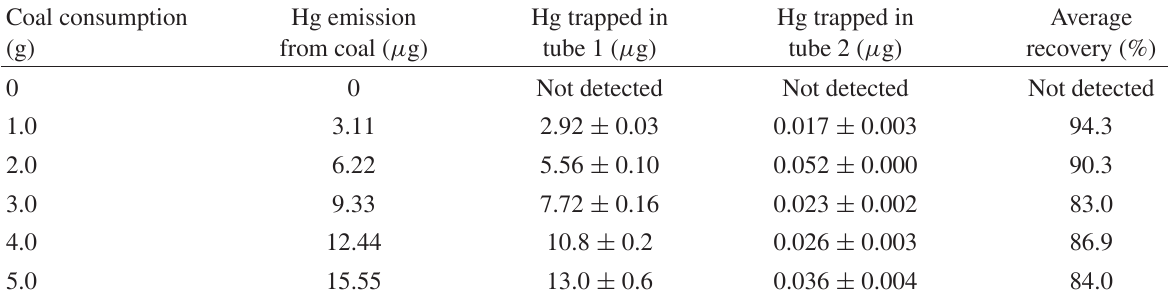
TABLE 4: Recovery between Hg trapped in flue gas and Hg emission from coal ( n = 3 ).